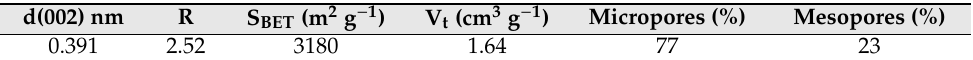
Table 1. Structural parameters, and pore parameters of